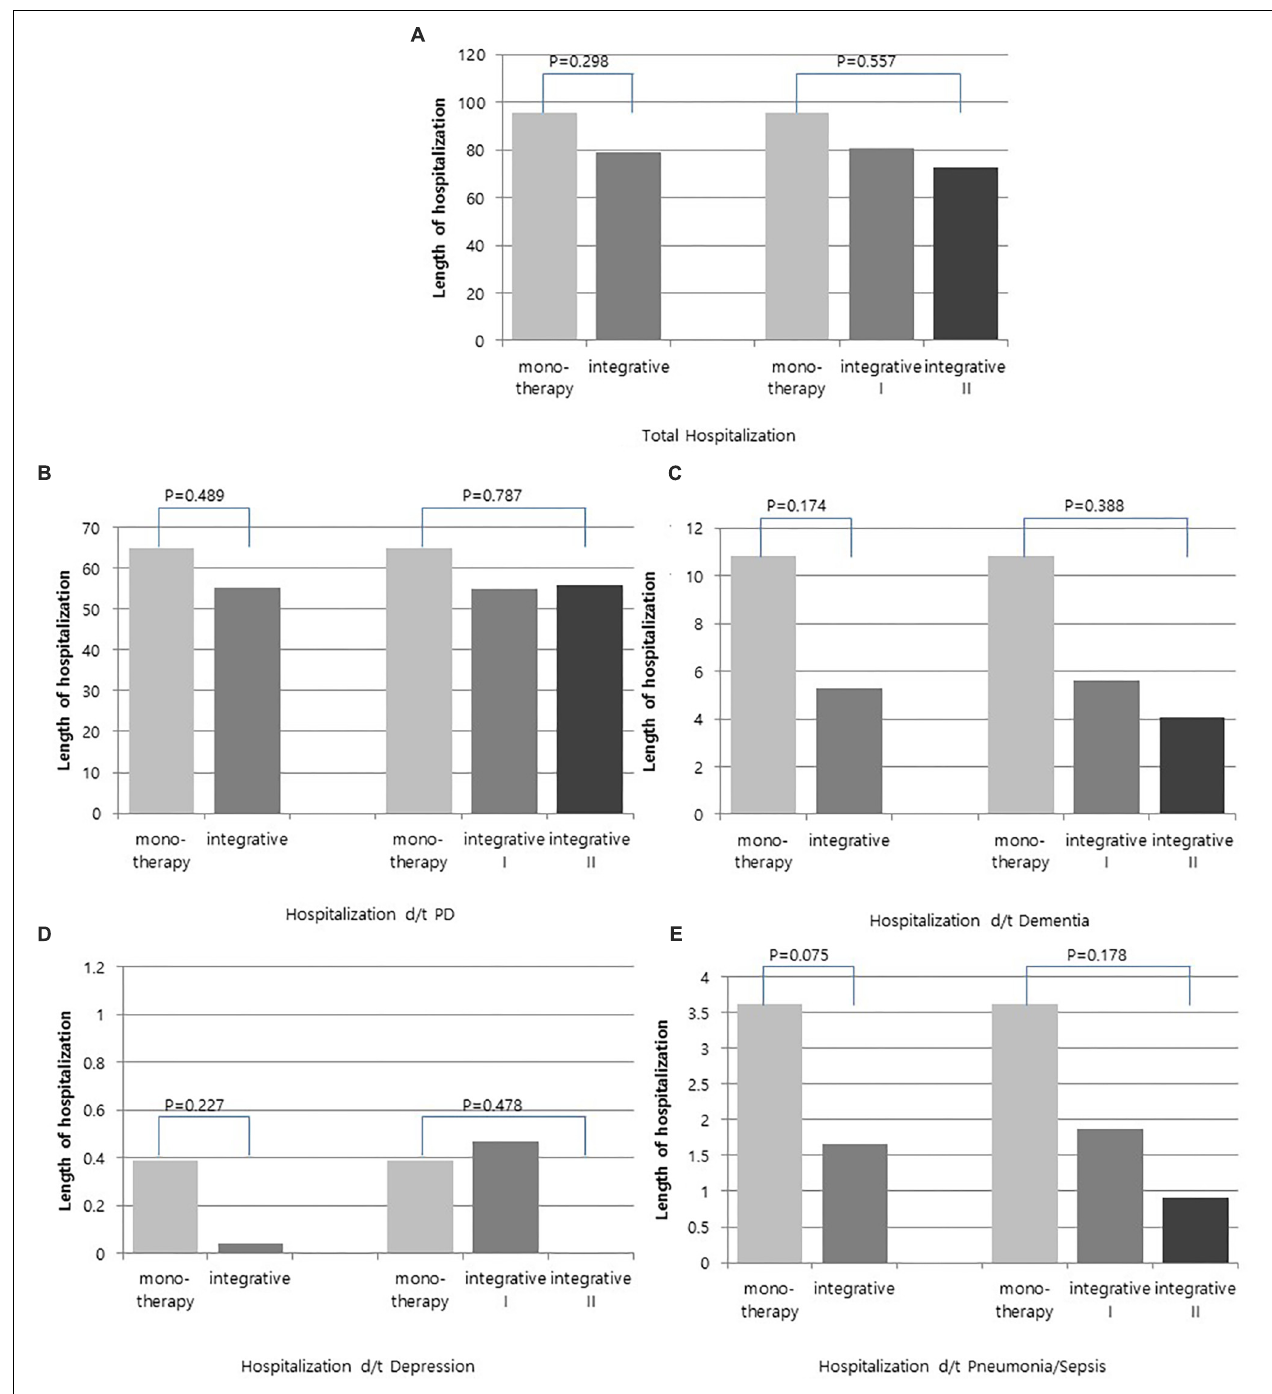
FIGURE 4 | Comparison of annual length of hospitalization between integrative therapy group and monotherapy group. (A) Total hospitalization, (B) Hospitalization d/t PD, (C) Hospitalization d/t dementia, (D) Hospitalization d/t depression, and (E) Hospitalization d/t pneumonia/sepsis.